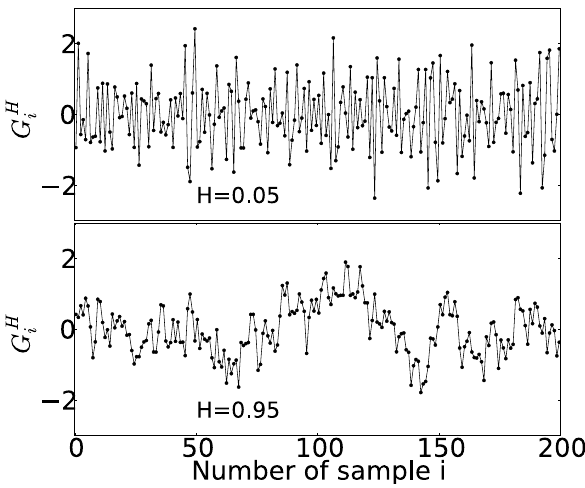
Fig. 1. (Top) Simulation of fractional Gaussian noise for N = 200 and H = 0 . 05. (Botton) Simulation of fractional Gaussian noise for N = 200 and H = 0 . 95. The difference in correlation structure is clearly visible.